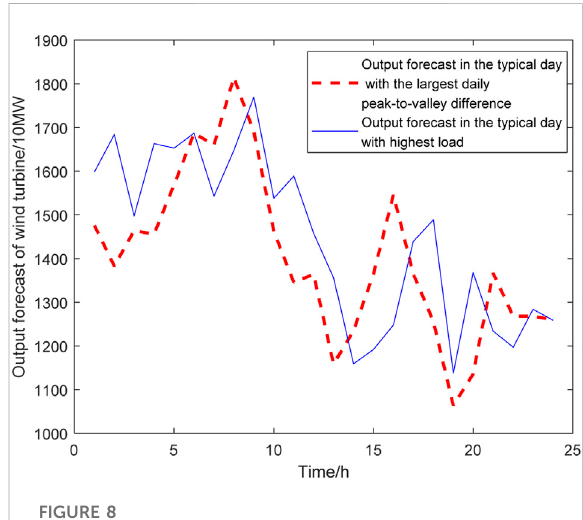
FIGURE 10 Comparison of the output of thermal power units on typical day 1 with 4 million kW interruptible loads.